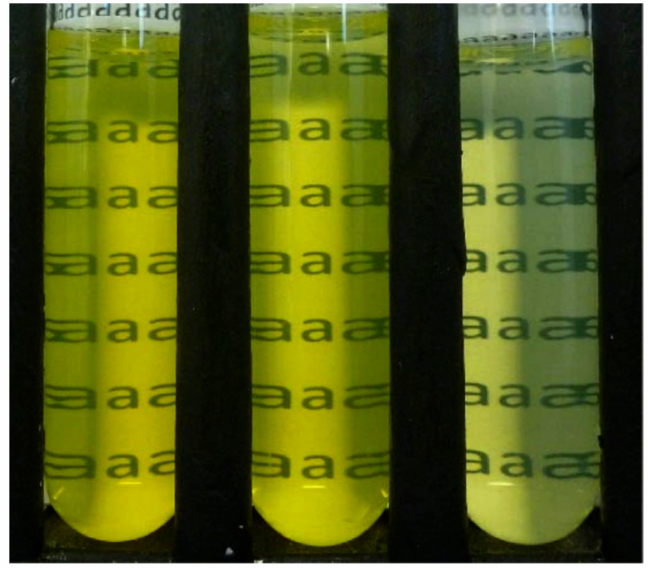
Figure 11. Curcumin-loaded zein-pectin core-shell nanoparticles were able to redisperse in water without any aggregation at three different concentrations of 8.8% (left), 4.25% (middle), and 0.84% (right). Reprinted with permission from ref. [76]. Copyright 2015